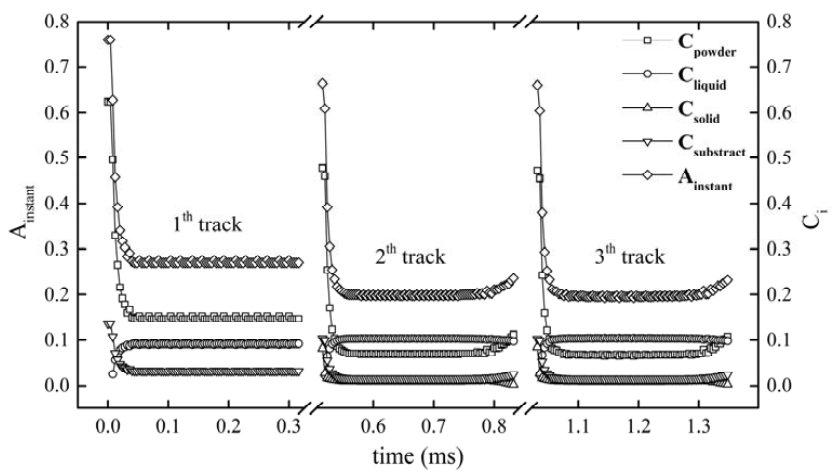
Figure 7. The evolution of A instant and C i with the development of time and track at the parameter set I. Materials 2018 , 11 , x FOR PEER REVIEW